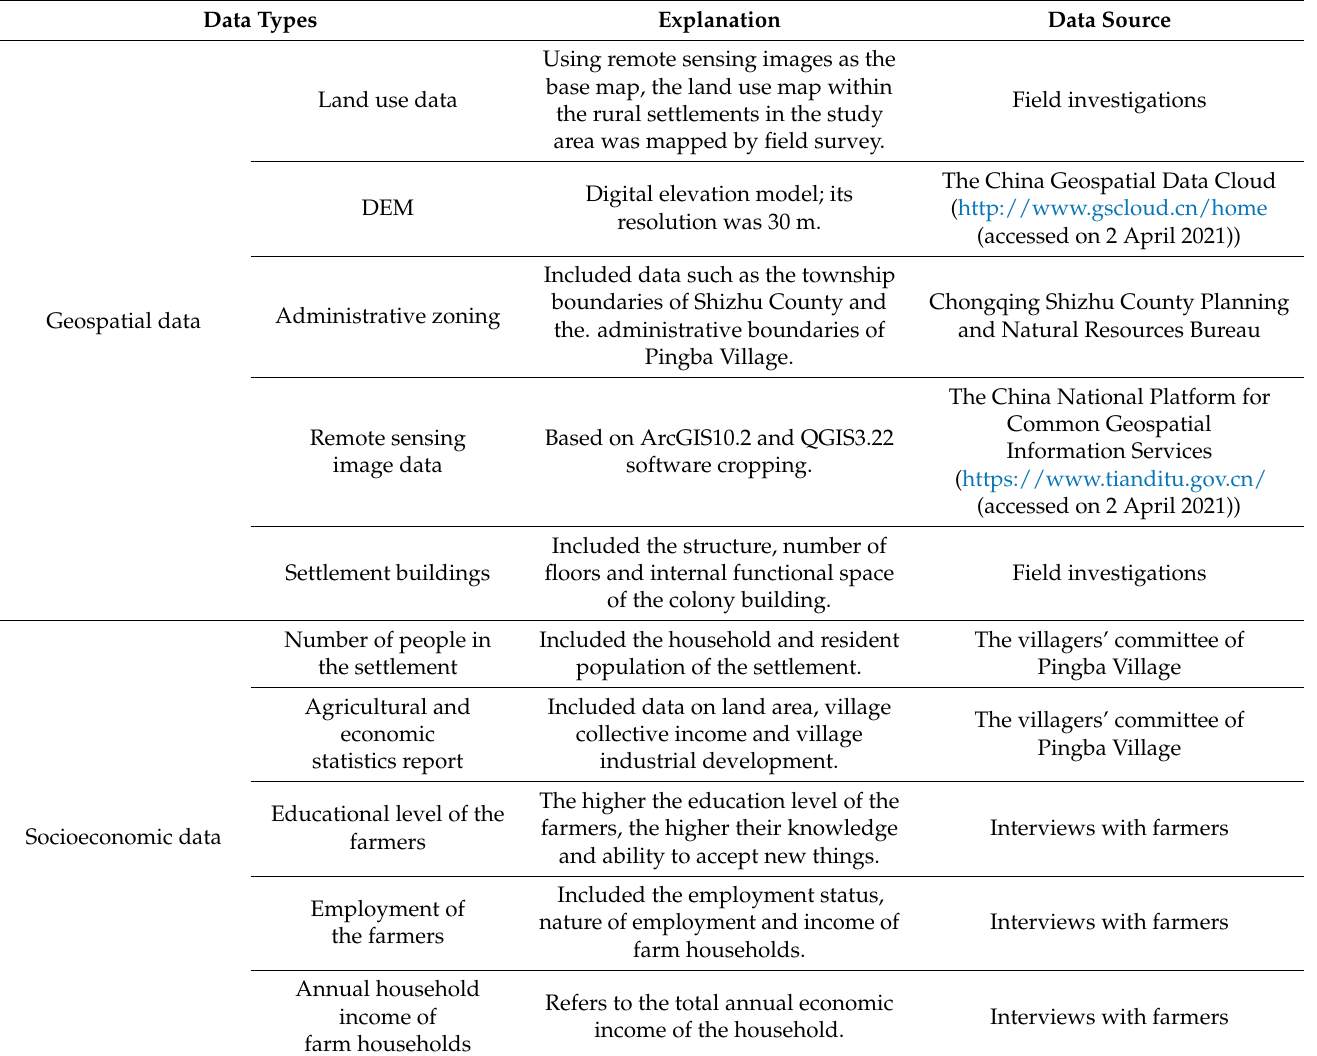
Table 1. Data types and